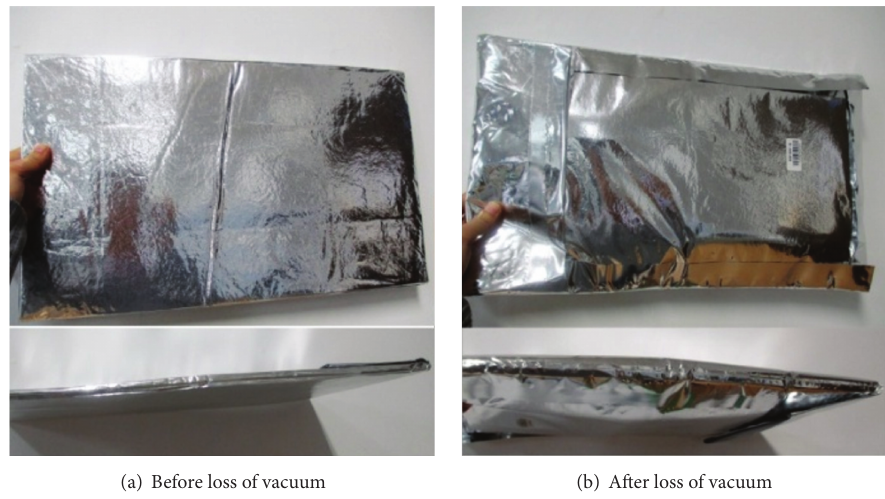
Figure 12: Comparison of VIP before and after puncture and loss of vacuum in China.